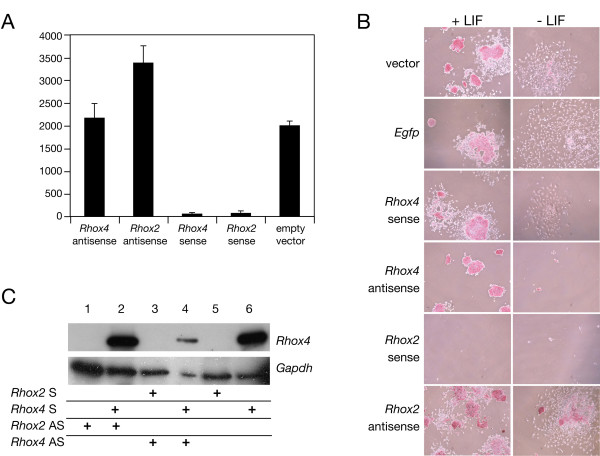
A. Total number of puromycin-resistant colonies generated after supertransfection of episomal vectors expressing Rhox2, Rhox4, anti-sense Rhox2, anti-sense Rhox4 or a control empty vector. Mann Whitney test revealed significant differences between control and Rhox2 sense (P < 0.03) and control and Rhox4 sense (P < 0.03). B. Alkaline phosphatase stained ES cell cultures after supertransfection with either an empty episomal vector (vector) or an Egfp-, Rhox4-, antisense Rhox4, Rhox2- or antisense Rhox2- expressing episomal vector. Transfected cells were selected in puromycin for 6 days and subsequently replating in the presence (+) and absence (-) of LIF. C. Western blot analysis of COS7 cells transiently co-transfected with vectors expressing sense (S) Rhox2 (lane 3 and 5) or Rhox4 (lanes 2, 4 and 6) and vectors expressing anti-sense (AS) Rhox2 (lanes 1 and 2) or anti-sense Rhox4 (lanes 3 and 4) showing efficient knockdown of RHOX4 protein product in the presence of anti-sense Rhox4 (lane 4) but not anti-sense Rhox2 (lane2). Blots were stripped and re-probed with GAPDH to ensure equivalent loading.